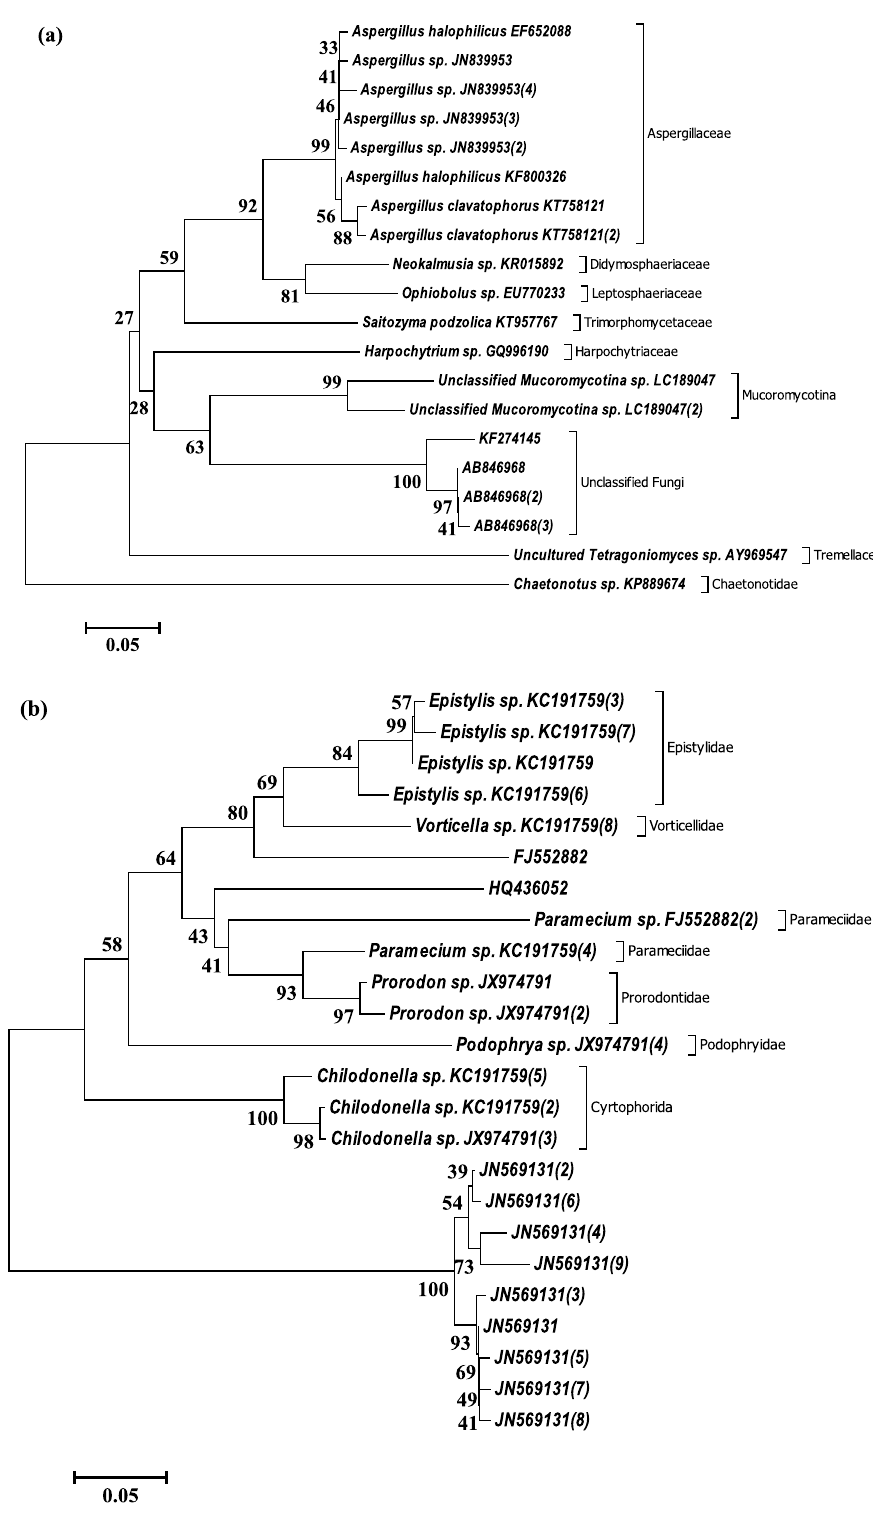
Figure 3. Evolutionary relationships of dominant OTUs of Eukarya showing selected strains of dominant Fungi ( a ), Animalia ( b ) and Plantae ( c ) taxa in AMD biofilm-water from ‘Onyeama’ coal mine. The evolutionary history was inferred using the Neighbor-Joining method. The percentage of replicate trees in which the associated taxa clustered together in the bootstrap test (1000 replicates) is shown next to the branches. The trees were drawn to scale, with branch lengths in the same units as those of the evolutionary distances used to infer the unrooted phylogenetic tree. The evolutionary distances were computed using the Maximum Composite Likelihood method Evolutionary analyses were conducted in